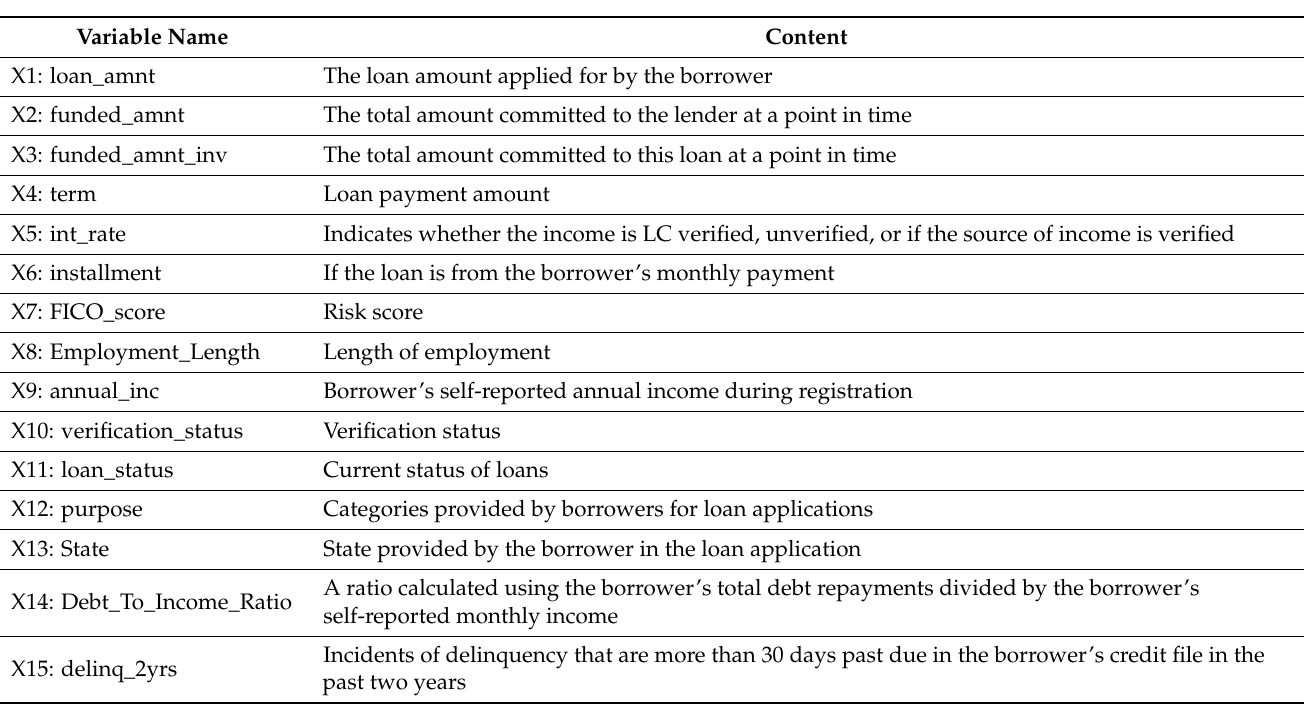
Table 2. Variable descriptions of the accepted loan